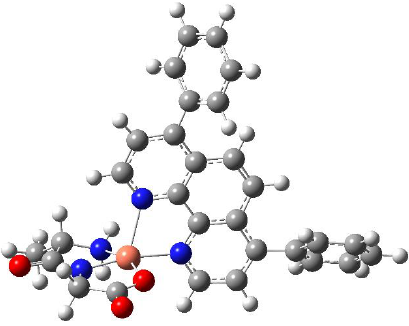
Figure 2. Optimized geometry for compound 3 .